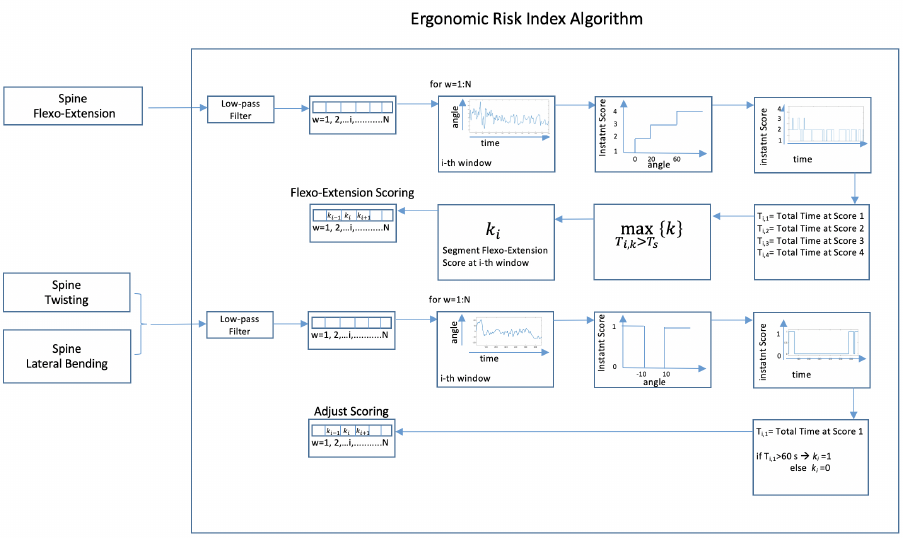
Figure 5. In this figure, the algorithm for estimating the scores related to each segment is shown. This algorithm is applied to neck and trunk: the thresholds applied to obtain the instant score, as shown, in the 4th block of each line, might vary for the two segments. In this case, the threshold values adopted for spine are shown. While the upper line is applied to flexo-extension, the lower line is applied for twisting and lateral bending, possibly resulting in an adjustment score ranging from 0 to